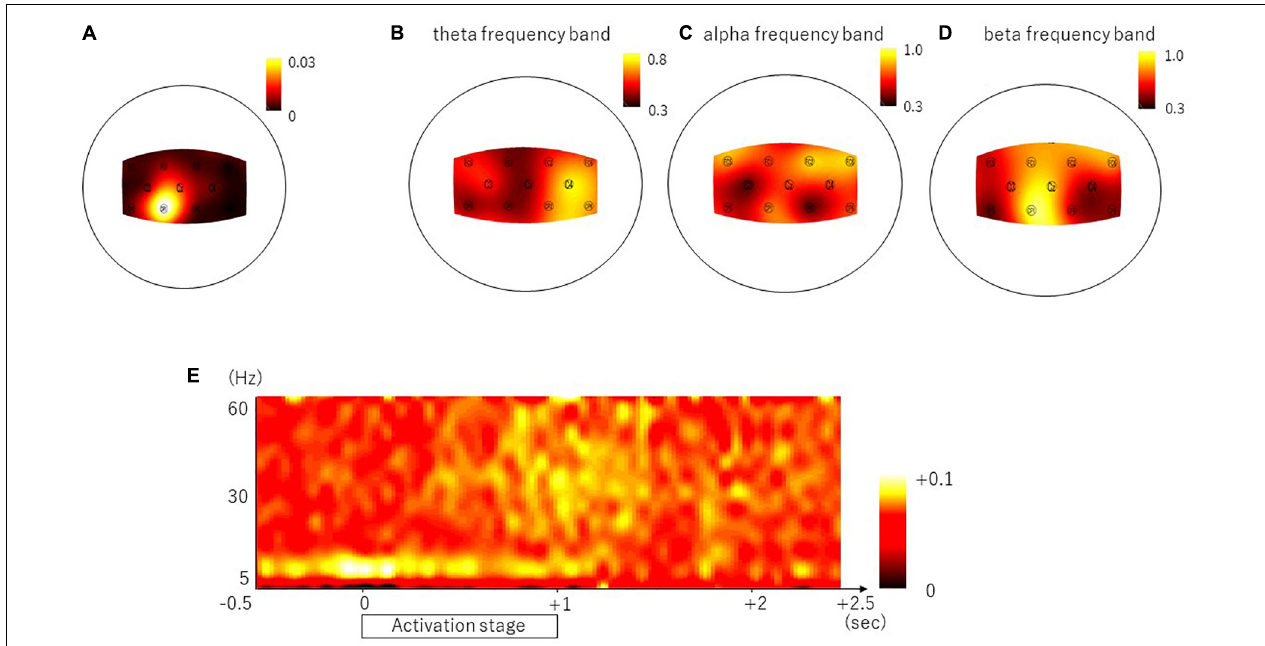
FIGURE 3 | Brain areas showing the representative result of the CMC, the ratio of subjects with significant coherence and the temporal property. Panel (A) shows the topomap display of the CMC in the representative subject whose peak value was found within beta frequency band (16 Hz). Panel (B–D) shows the topomap displays of the ratio of the subjects with significant coherence in the theta frequency band (B) , alpha frequency band (C) , and beta frequency band (D) . The temporal property is shown in panel (E)